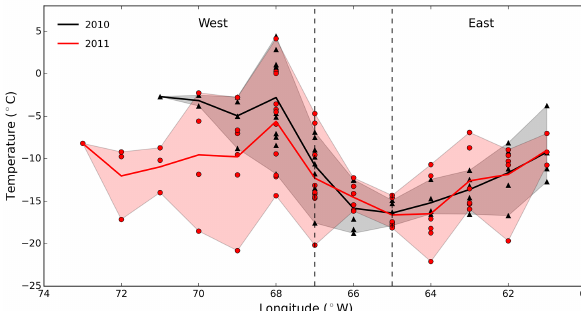
Figure 4. Atmospheric temperature as measured by the aircraft ( ◦ C) as a function of longitude, averaged in 1 ◦ longitude bins. The flight- averaged values are overplotted as black triangles (2010) and red circles (2011). Solid lines represent the average of these averages in each longitude bin. Shaded grey (2010) and red (2011) areas indi- cate the spread of these averages across the peninsula. The vertical dashed lines delimits the western and eastern regions of the penin- sula as defined in this